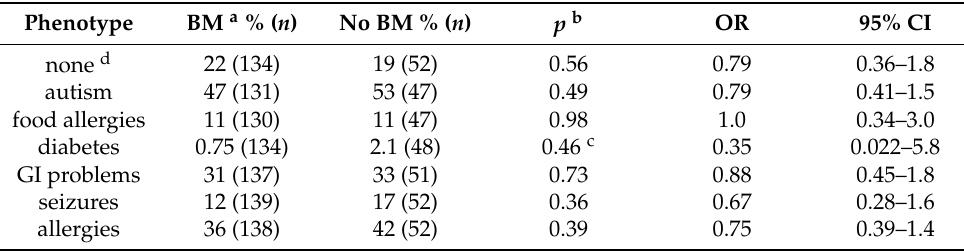
Table 2. Analysis of FXS comorbidities as a function of any breast milk.